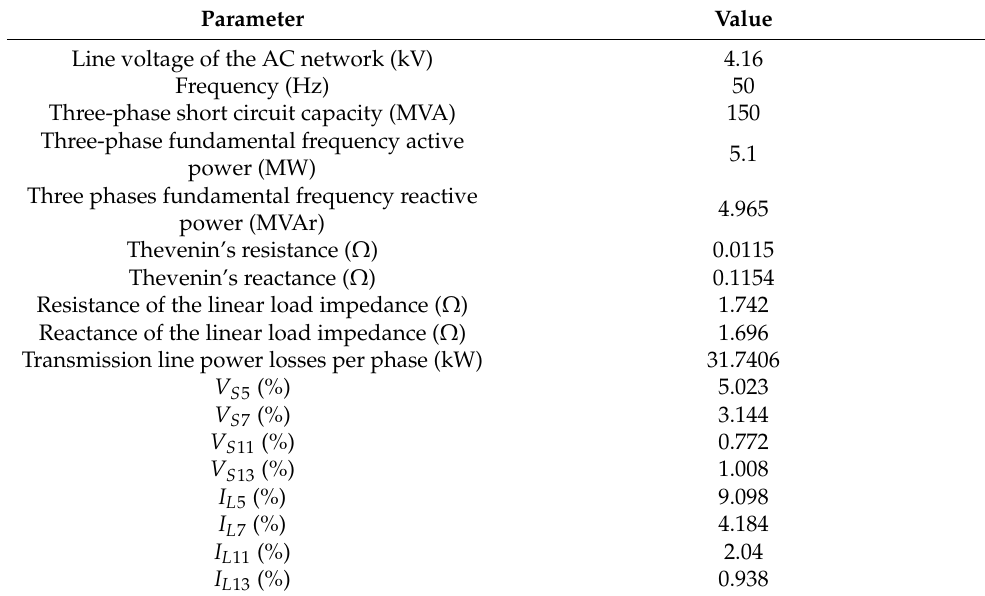
Table 1. System data.